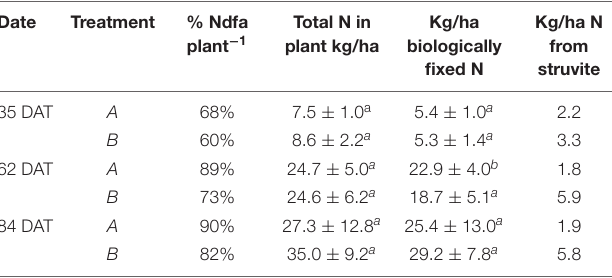
TABLE 2 | Results for percentage of Nitrogen derived from atmospheric N 2 fixation (%Ndfa) in plant, Total amount of N in plant expressed in kg/ha (Leaves + Shoot + Root + Beans) and Biologically fixed N expressed in kg/ha.